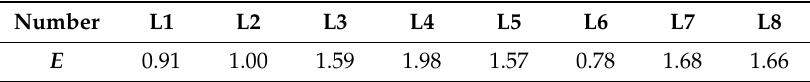
Table 4. Energy dissipation coefficient.